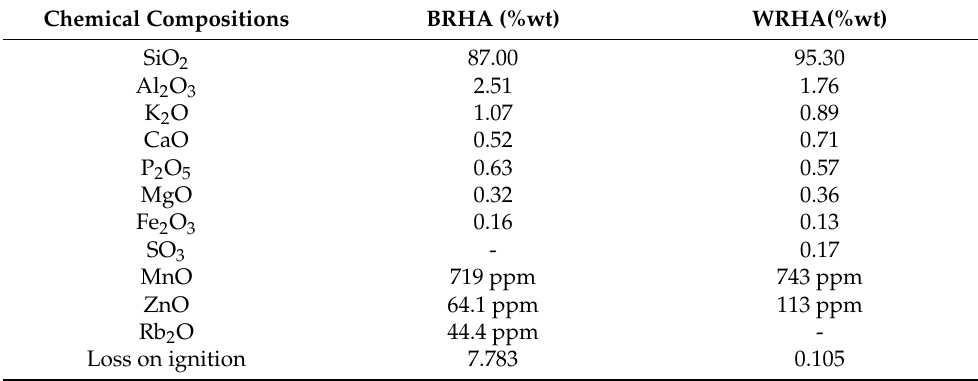
The SEM images of BRHA and WRHA particles are shown in Figure 1a,b, respectively.